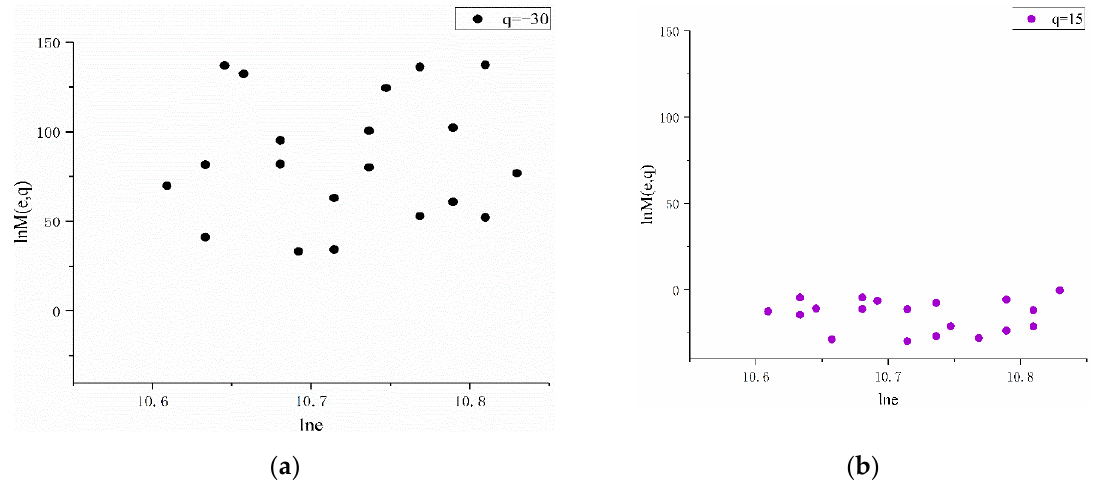
Figure A3. The relationship of ln 𝑀(𝑒, 𝑞) and ln 𝑒 in the Weihe River Basin. ( a ) The relationship of ln 𝑀(𝑒, 𝑞) and ln 𝑒 when e is [40,000, 50,000] and q is −3 0; ( b ) The relationship of ln 𝑀(𝑒, 𝑞) and ln 𝑒 when e is [40,000, 50,000] and q is −1 5.